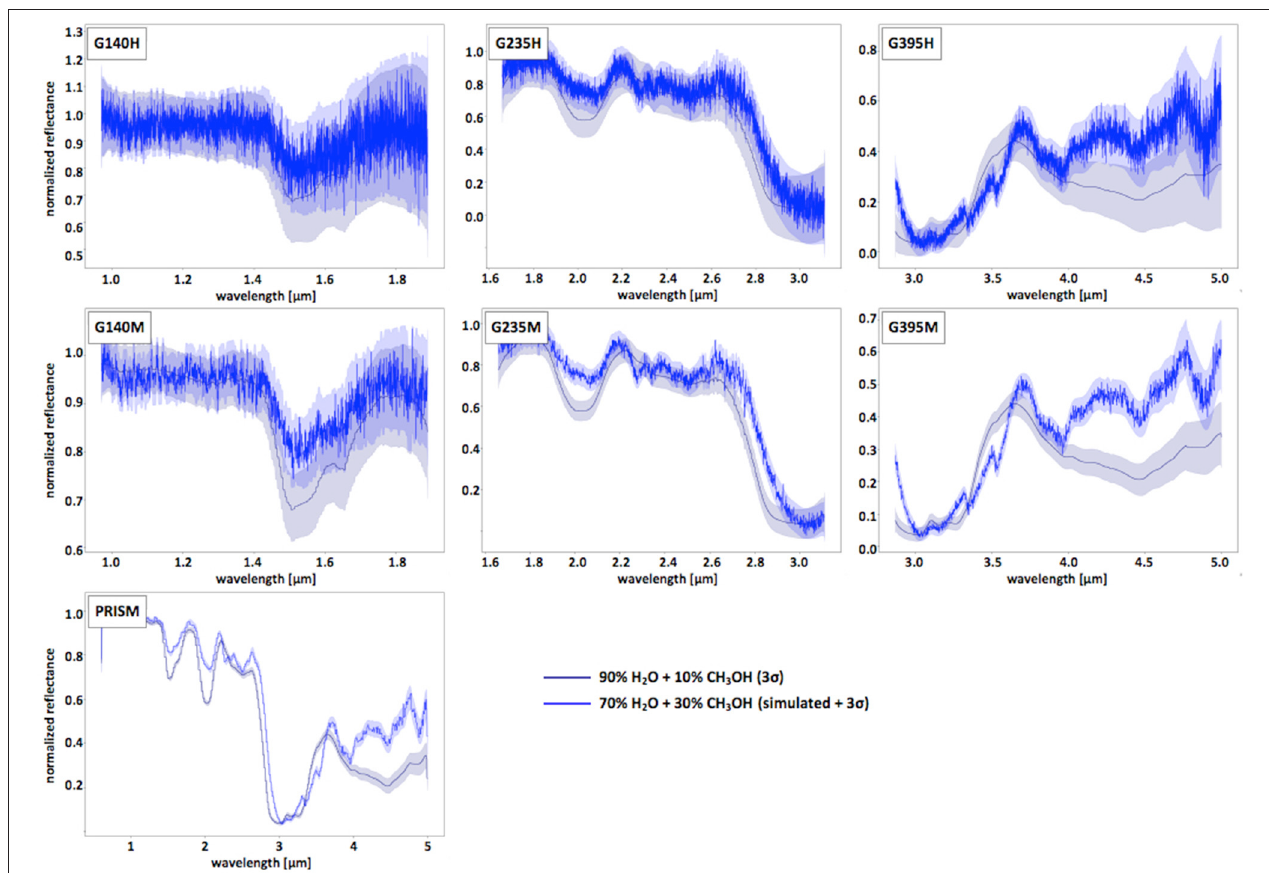
FIGURE 2 | Simulated spectra for two mixtures of water and methanol ice, shown (from top to bottom) for the high-, medium- and low-spectral resolution elements, respectively. The simulated signal is shown for one mixture for clarity. Shaded areas show the 3- σ detection limits corresponding to the simulated signal-to-noise ratios. Exposure time and other relevant instrumental features may be found in Table 2